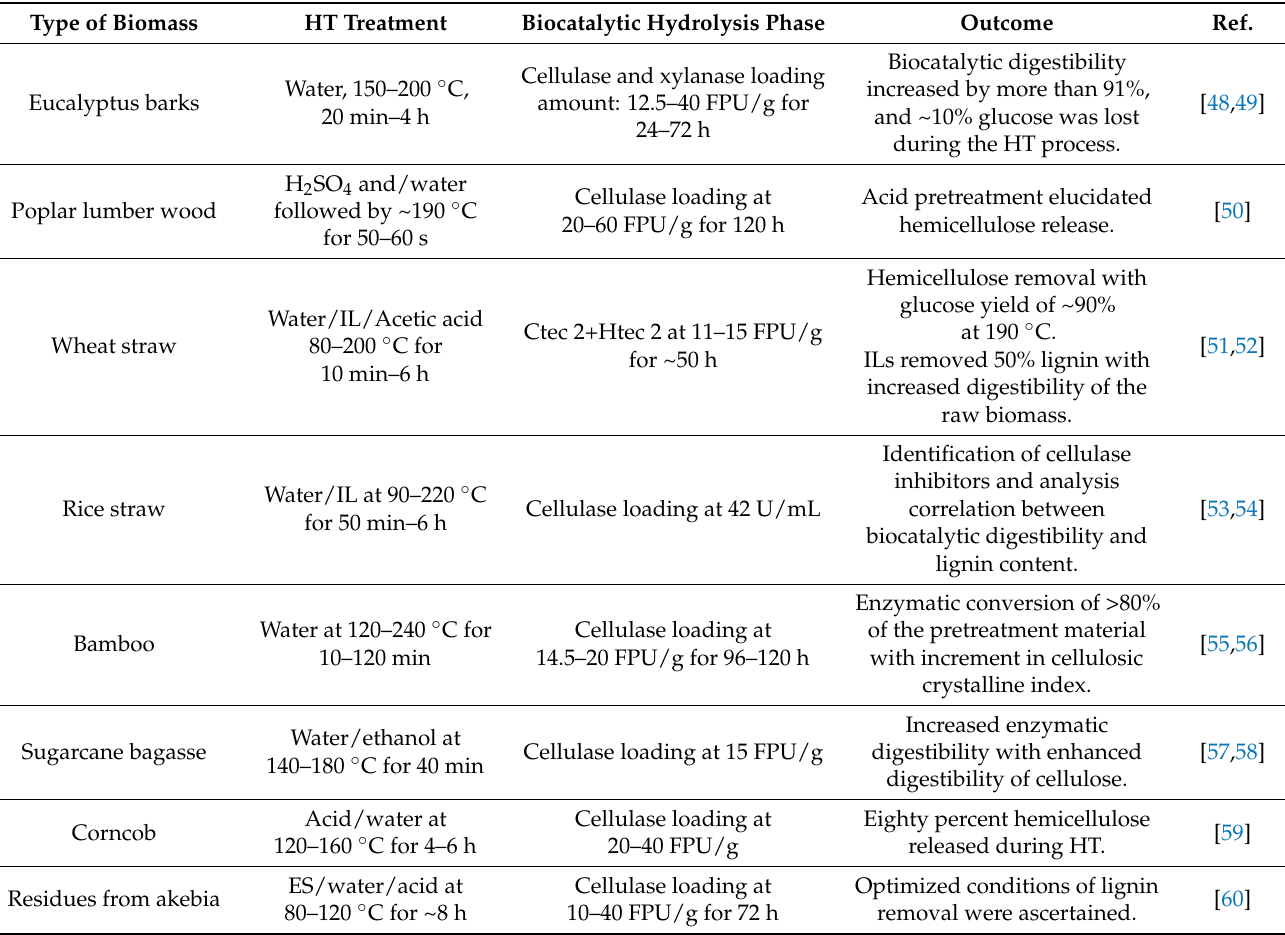
Table 1. Summary of the literature related to the combined HT pretreatment and enzymatic hydrolysis studies for biomass